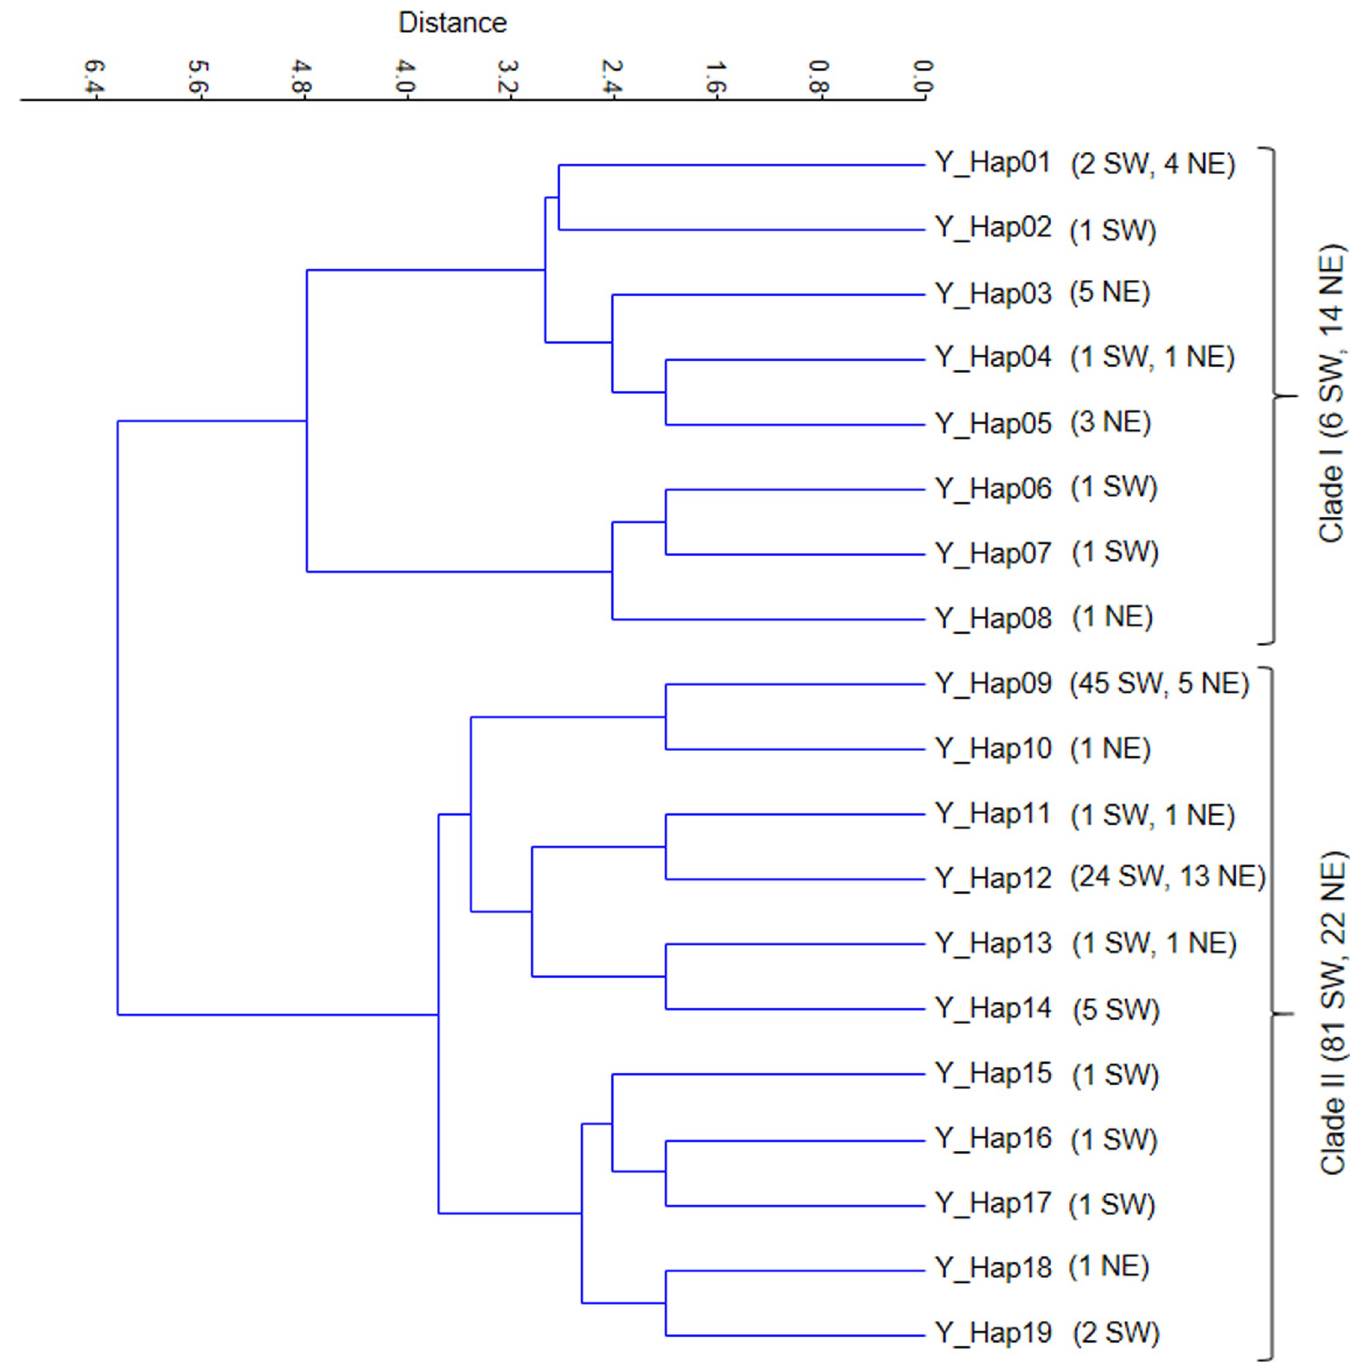
Fig 4. UPGMA dendrogram of the 72 X-haplotypes found in 123 red deer stags. The numbers of SW and NE samples belonging to the haplotypes are in brackets. https://doi.org/10.1371/journal.pone.0242506.g004 independent sample set of 100 deer [35]. Patterns and the cognate allelic frequencies are differ- ent in SW and NE Hungary (site T108 provides a typical example, Fig 5). The F the substructure parameter of the population differences) calculated is 0.030; the diversity